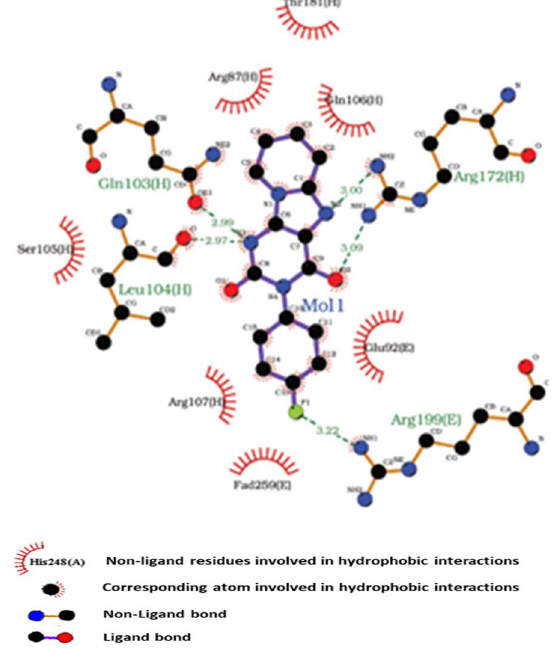
Figure 3. Hydrogen bond and hydrophobic interactions between the binding site of ThyX from Mycobacterium tuberculosis complex and 9a . The green dotted lines depict the hydrogen bonds whereas the other residues represent the hydrophobic interactions with the respective compounds.